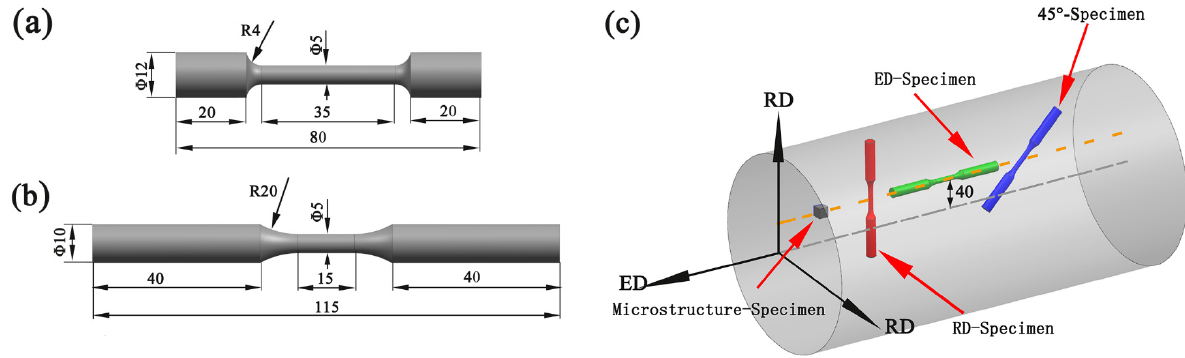
Figure 1. Specimen designs for ( a ) tensile tests, ( b ) fatigue tests; ( c ) The extraction locations of specimens in the extruded 7075 Al alloy (Dimensions are in “mm”).